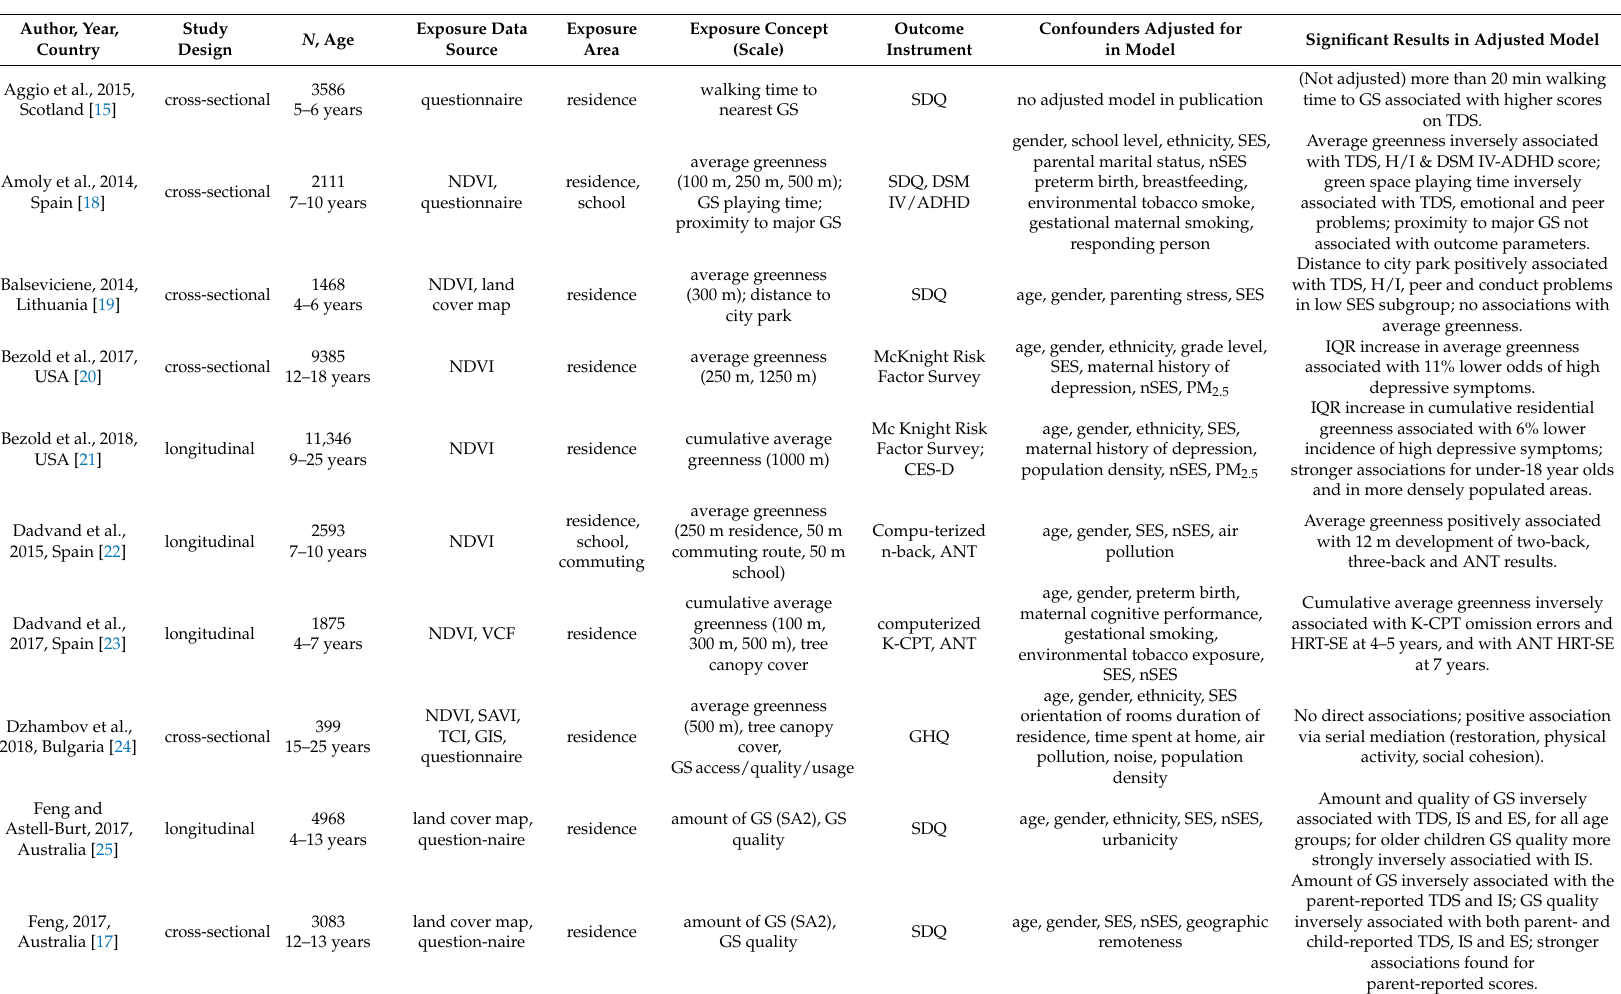
Table 1. Study characteristics, methodology and